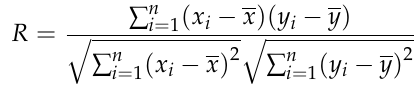
Figure 8. SO 2 and CO 2 trend over time. To confirm this observation in a quantitative way, we calculated Pearson’s correla- tion coefficient R according to the standard definition: 𝑅 (cid:3404)